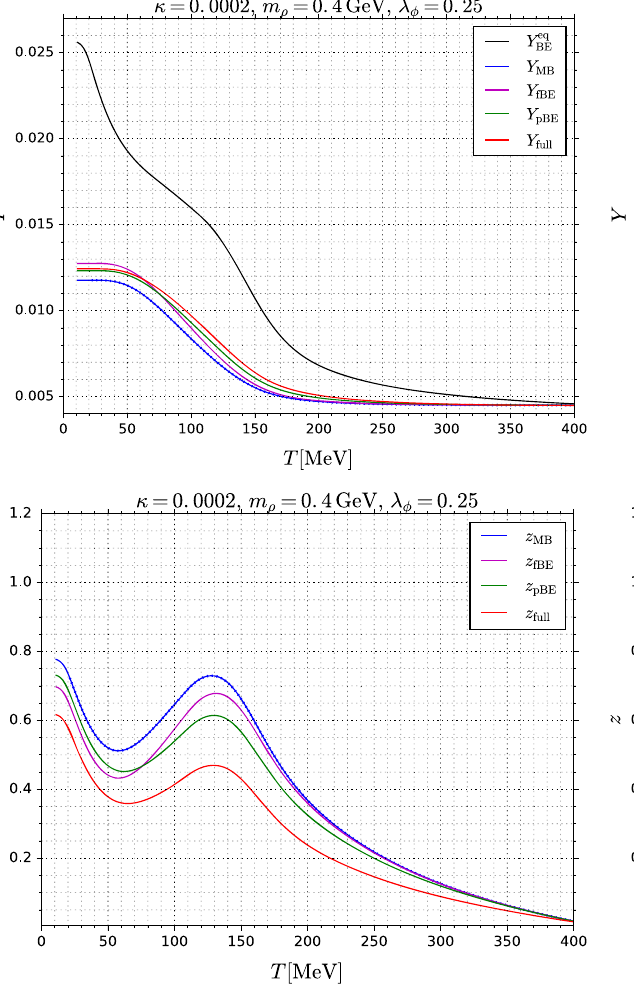
left panel of Fig. 1. Line colors (corresponding to the methods used) are described in the legends. Dashed blue line in the upper right panel denotes the instantaneous freeze-out approximation result (see Fig.